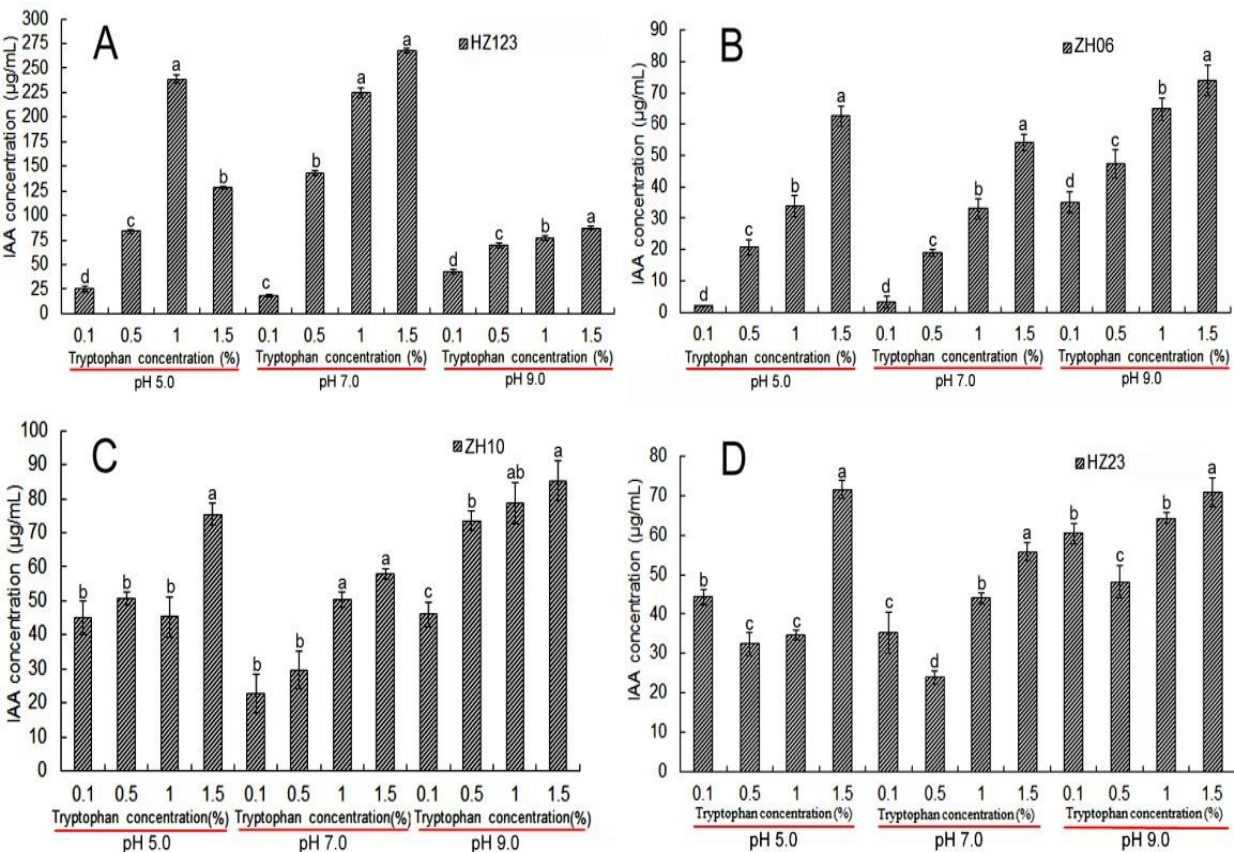
Figure 3. IAA production of the four isolates in the medium amended with different concentrations of tryptophan at different pH values. ( A ) HZ123. ( B ) HZ06. ( C ) HZ10. ( D ) HZ23. Values within the same treatment with different low-case letters are significantly different ( p ≤ 0.05).